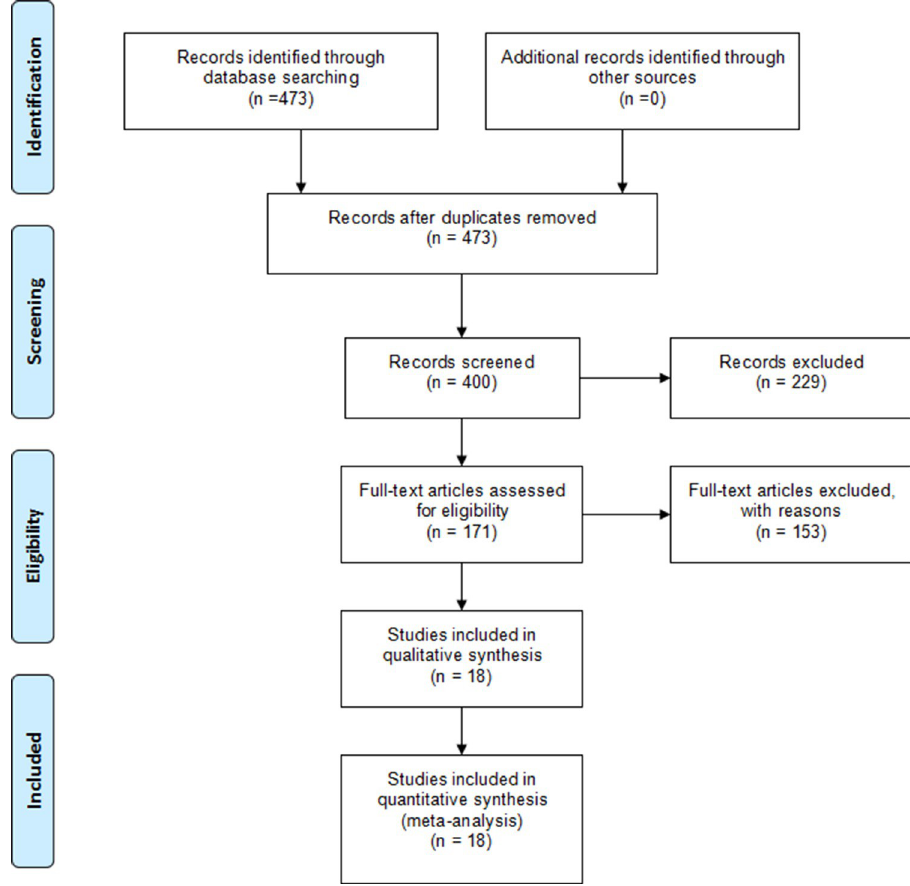
Fig 1. Flowchart of studies included in this